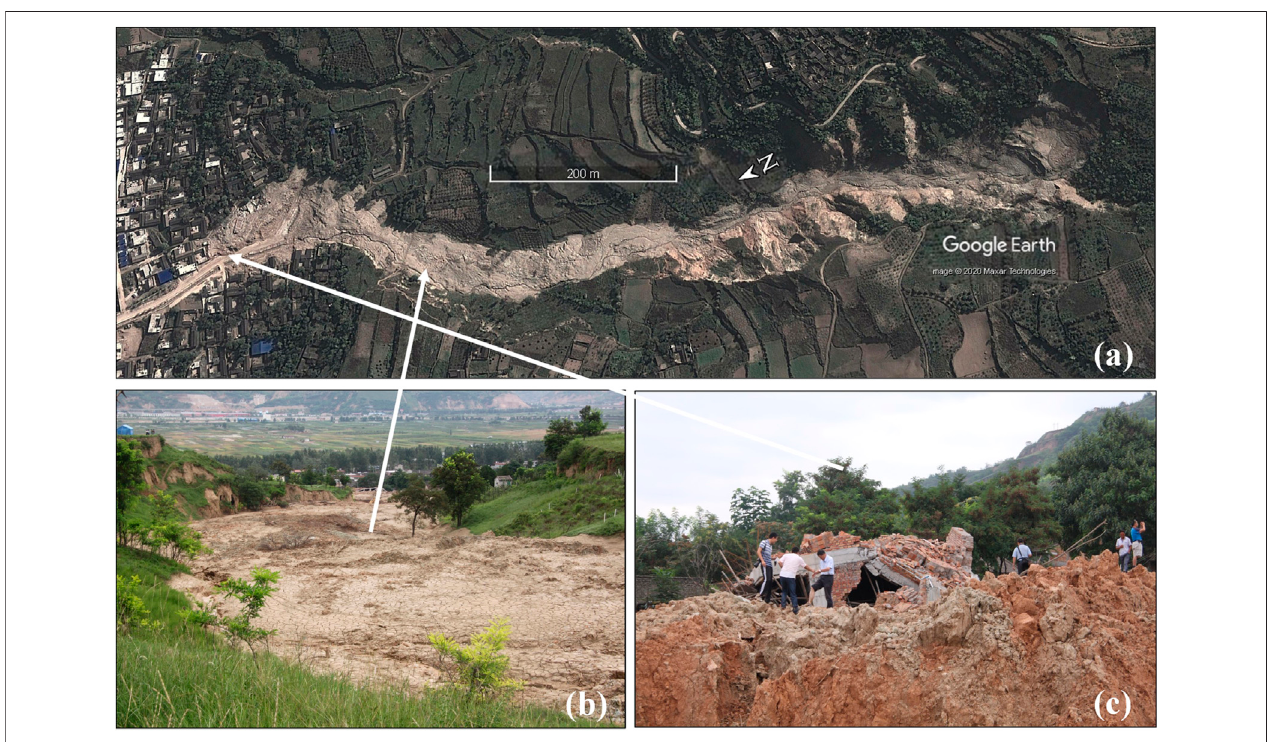
FIGURE 2 | The characteristics of loess mud fl ows on loess platforms. (A) A loess mud fl ow that occurred near Jiangliu Village on March 9, 2016 on the South Jingyang Platform in Xi ’ an, China; (B) A loess mud fl ow occurred near Chenjia Village in 2015 on the Heifangtai Platform, Gansu.